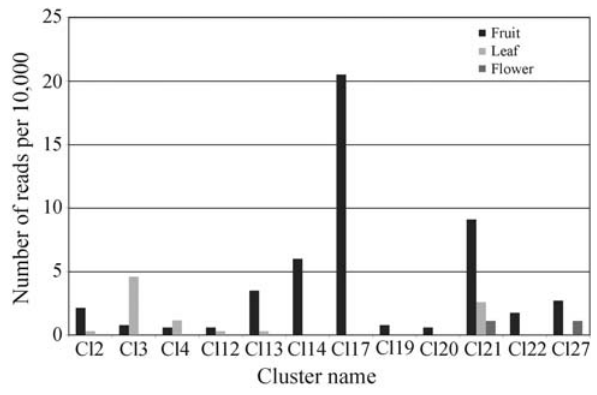
Figure 3 - Gene expression of terpene synthases in sweet orange. The terpene synthases expressed in fruits were analyzed in silico for their ex- pression in other tissues. The reads were counted and normalized to 10,000 reads.